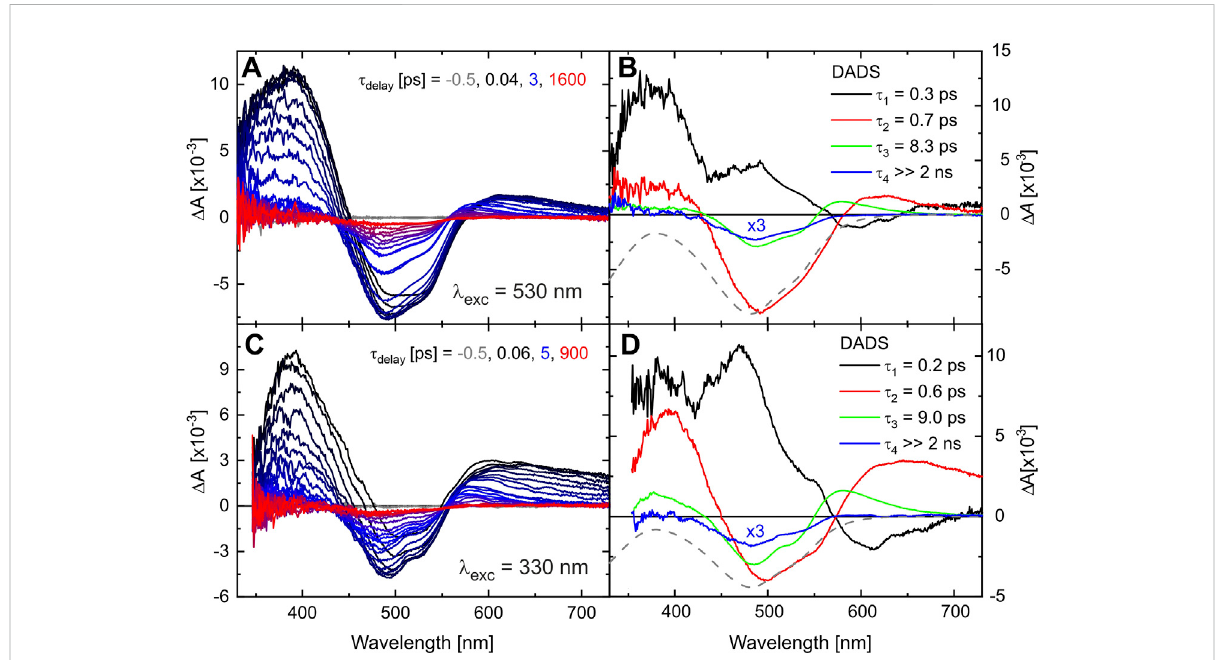
FIGURE 3 Transient absorption of TPF in methanol after excitation at 530 nm (A) and 330 nm (C) after de fi ned delay times on a fs-ns time scale. The corresponding DADS from a global exponential fi t to the data are given in (B,D) . The scaled and inverted absorption spectrum of the initial sample is given by a gray-dashed line for